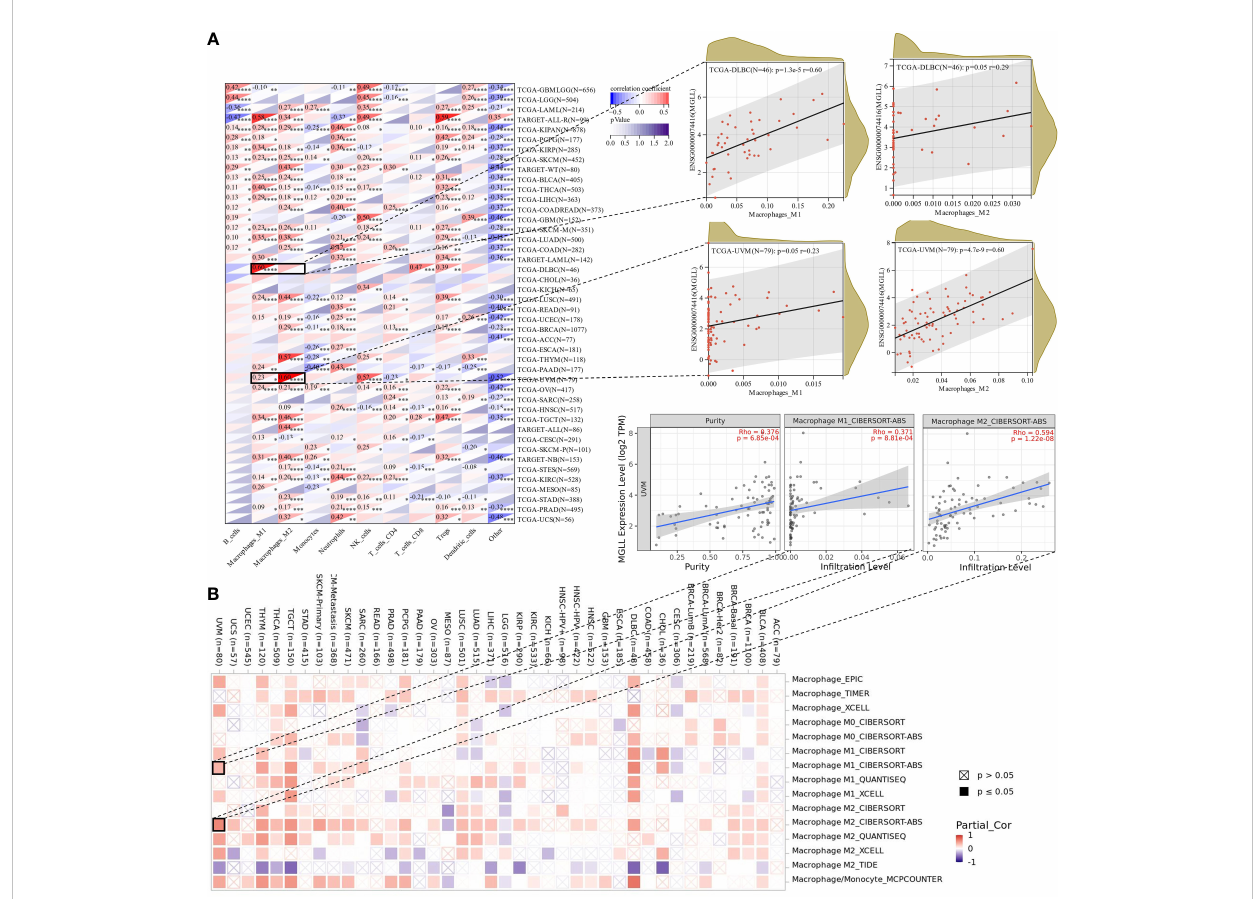
FIGURE 8 Assessment of immune in fi ltration. (A) Using the QUANTISEQ method, MGLL expression and immune cell in fi ltration were associated in the UCSC dataset. (B) Various algorithms identi fi es a relationship between MGLL expression and macrophages in different types of cancer from the TCGA database. *p < 0.05; **p < 0.01; ***p < 0.001; ****p <